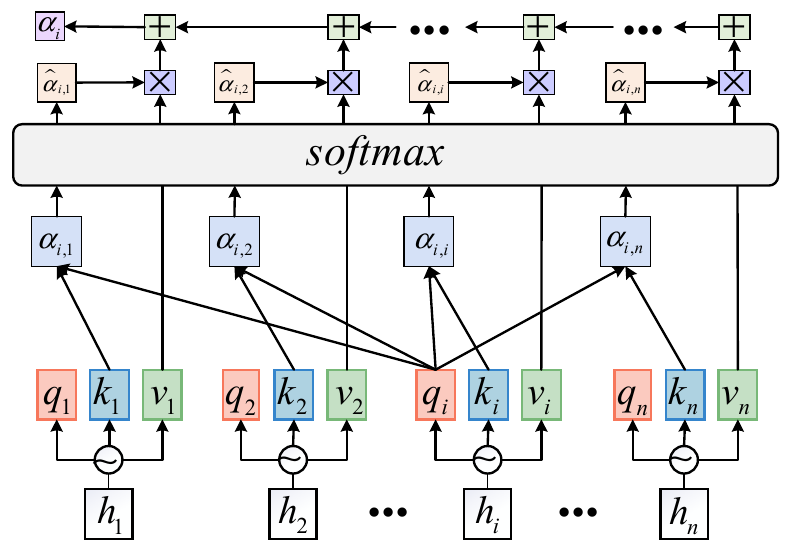
h . Figure 2. Calculation process of self-attention for h i . i √ d of q i for each key k j is √ d to have